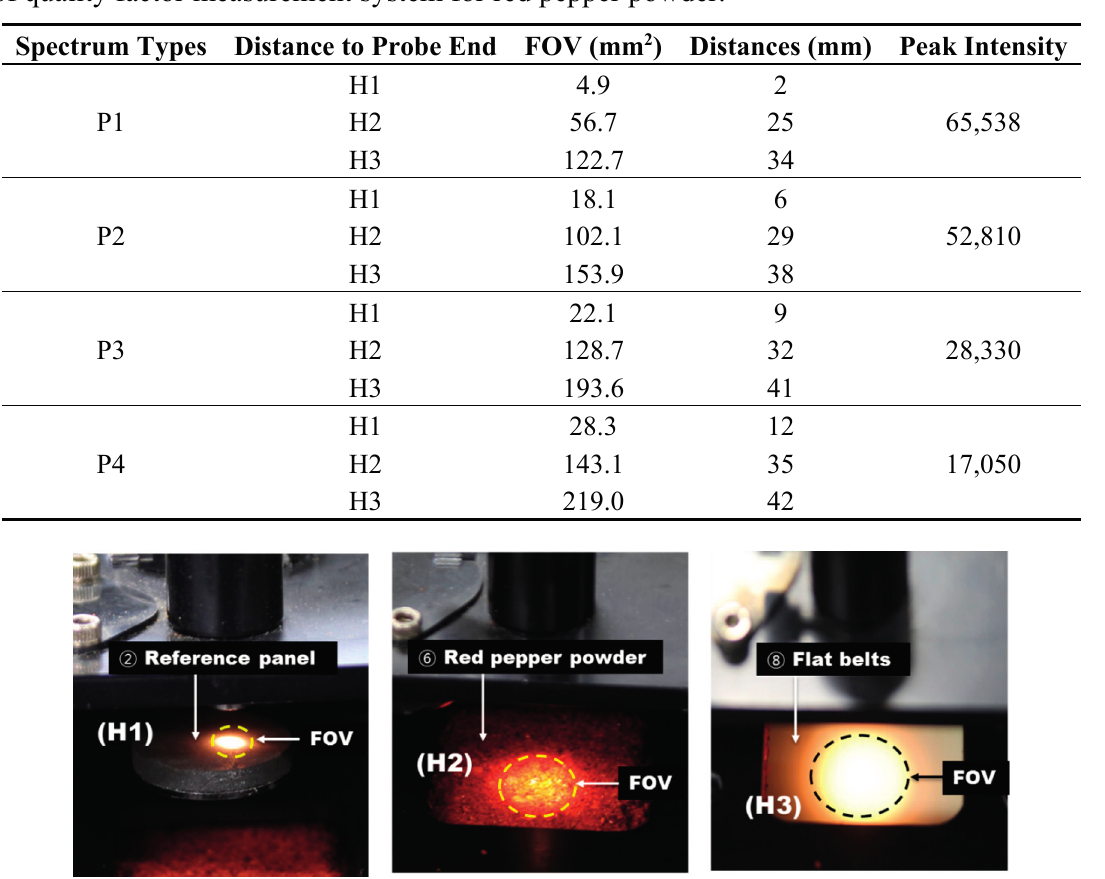
Figure 11. Shape of the incident light spot on the surface of the reference panel (H1), red pepper powder (H2), and flat belts